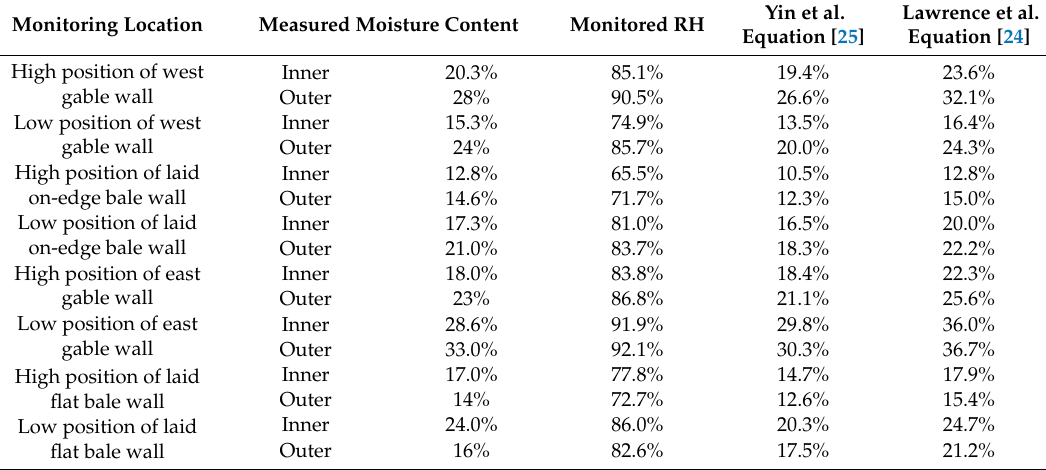
Table 2. Monitored moisture content and calculated moisture content from isothermal models.